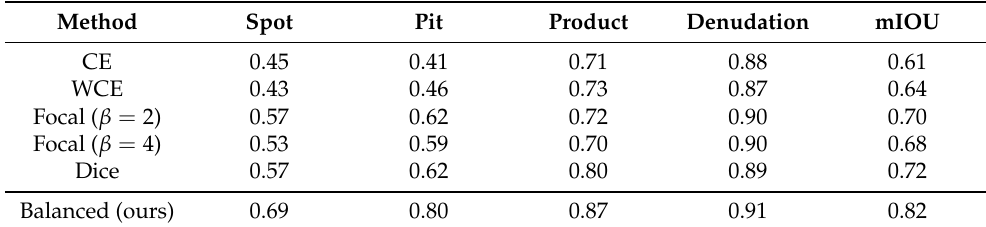
Table 5. Class-wise IoU and mIoU of U-Net trained on aluminum alloy surface defect dataset with different loss functions.